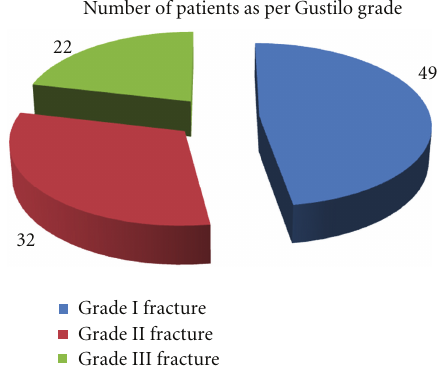
Figure 1: Fractures as per Gustilo